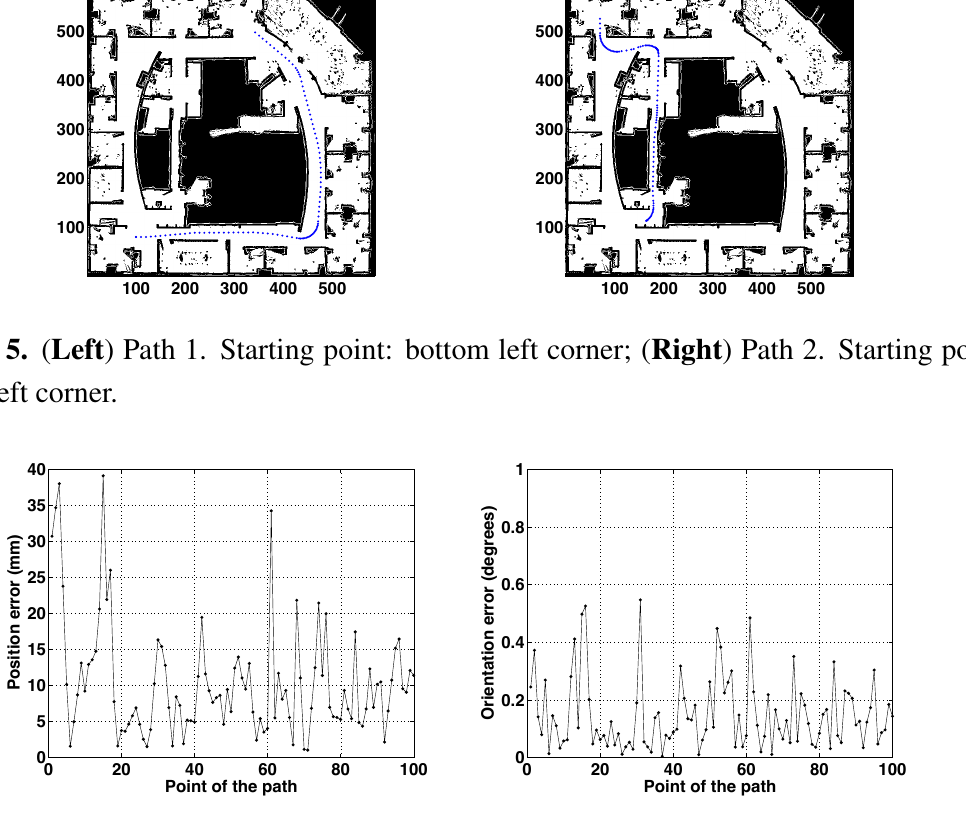
Figure 6. Path 1. Errors vs . point of the path. ( Left ) Position error; ( Right ) orientation error.